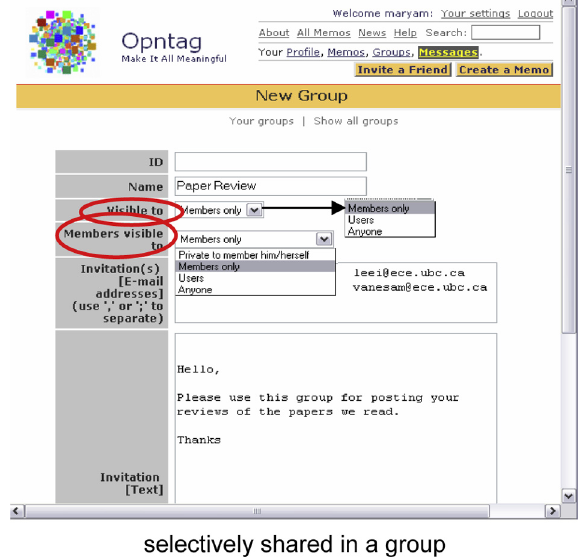
Figure 5. Classic group definition page with group and member list visibility menus.